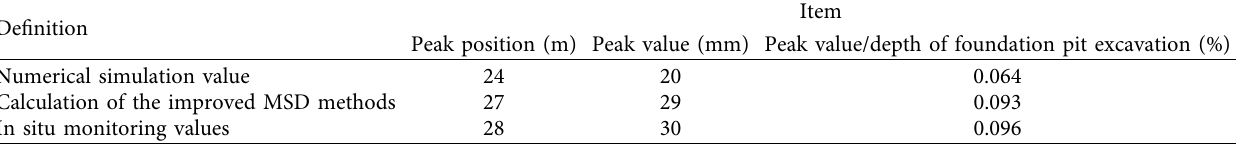
Table 4: Comparison of the pole peak position of horizontal